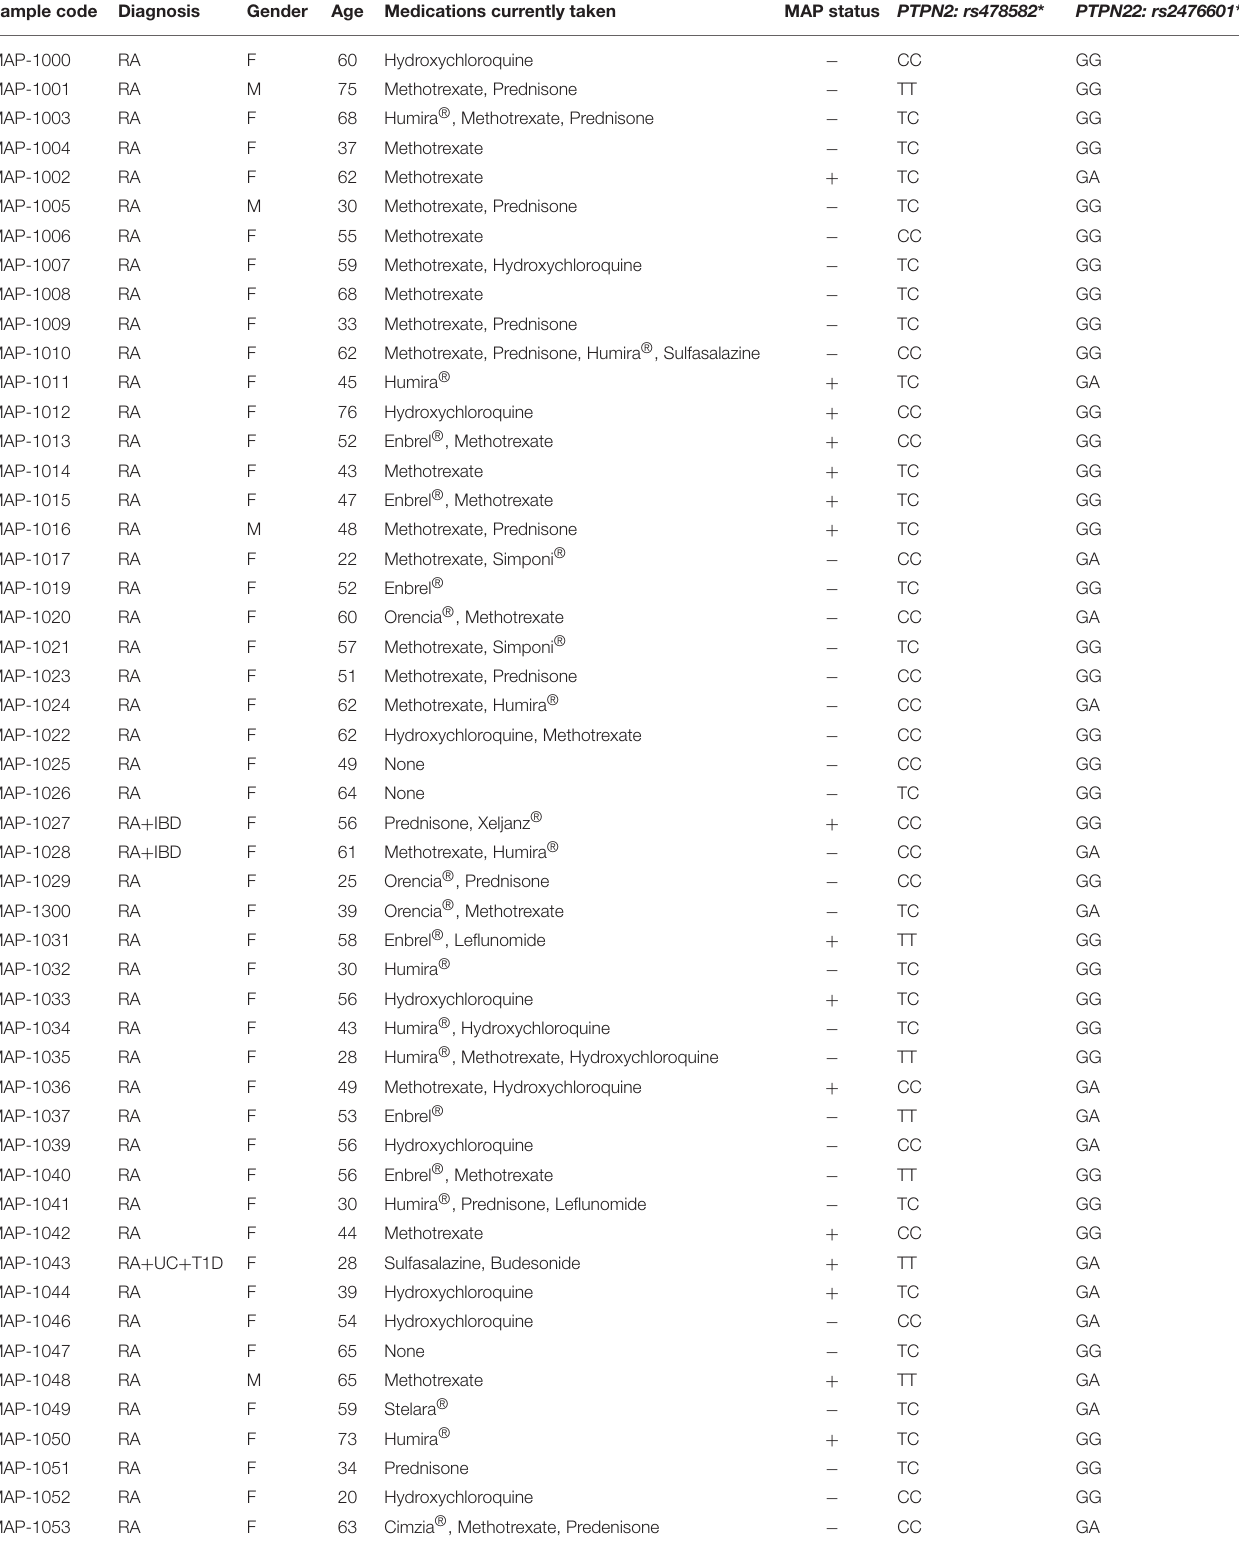
TABLE 1 | Demographics, treatment history, and results of MAP and allele frequency of rs478582/rs2476601 in RA samples used in study. Sample code